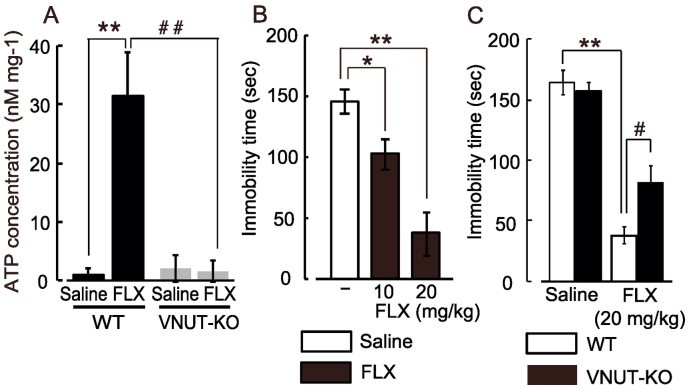
Extracellular ATP within the hippocampus and FLX-induced anti-depressive behavior caused by VNUT-deletion.(A) Measurement of extracellular ATP content in the artificial cerebrospinal fluid (ACSF) media of hippocampal slices taken from WT and VNUT-KO mice 21 days after the chronic administration of FLX (mean ± SEM, n = 4). **p < .01 vs. WT saline group, ##p < .01 vs. littermate control FLX group. (B) Anti-depressive effects in mice were assessed by TST. WT (C57BL/6 J) mice were administered with saline or FLX (10 and 20 mg/kg per day, p.o.) for 3 weeks. TST was performed 1 h after the final FLX-administration. Data show the mean ± SEM of immobility times (n = 6). *p < .05 and **p < .01 vs. saline. (C) VNUT-KO mice (C57BL/6 J background) were administered with saline or FLX (20 mg/kg per day) for 3 weeks, and TST was performed. Data show the immobility times (mean ± SEM, n = 5). #p < .05 vs. WT, **p < .01 vs. saline group.